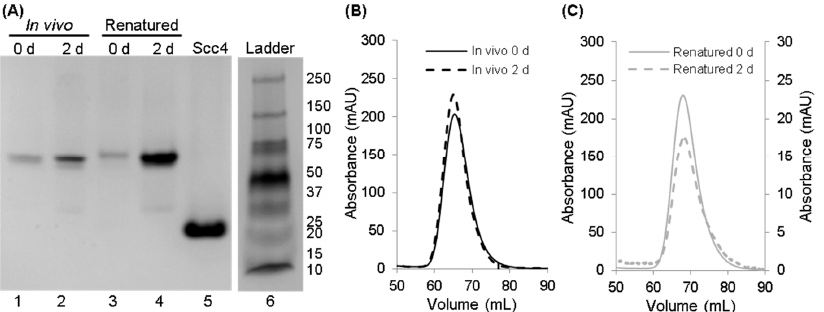
Figure 6. Native PAGE and qualitative SEC analyses to compare the stability of the in vivo-associated and renatured complexes of Scc4:His 6 -Scc1. ( A ) Native PAGE of the in vivo-associated complex (lanes 1 and 2) and the renatured complex (lanes 3 and 4) after purification and after 2 days at room temperature. Lane 5 is Scc4 for comparison. Lane 6 is the Bio-Rad Precision Plus protein ladder with molecular weights listed to the right in kDa; the ladder was included as a qualitative guide. The full gel from which these lanes were extracted is shown in Figure S8. ( B , C ) Qualitative SEC analysis to assess the stability of ( B ) the in vivo-associated complex after purification (0 d, black solid line) and after 2 days at room temperature (dashed black line) and ( C ) the renatured complex after purification (0 d, gray solid line) and after 2 days at room temperature (dashed gray line). ( C ) The right vertical axis corresponds to the renatured complex after 2 days; a smaller amount was analyzed to reverse the bulk of the sample for NMR analysis. Di ff erences in the elution times between the ( B ) in vivo- and ( C ) on-column-associated complexes are not interpretable (refer to Section 2.5 for